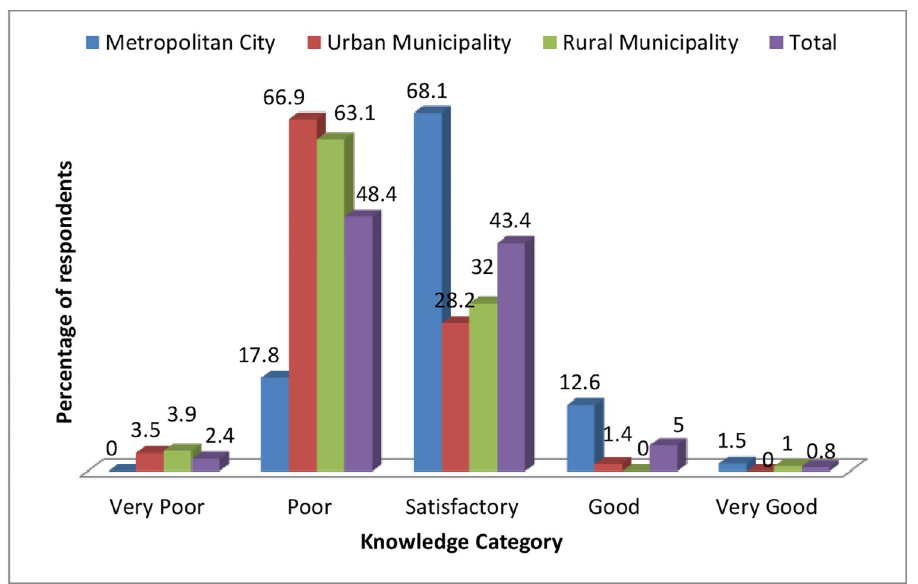
Fig 2. Level of student’s knowledge score on diabetes and hypertension.